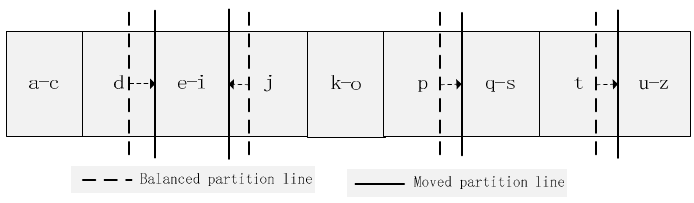
Figure 3. Balanced Partition with Partition Line Adjustment (BP_PLA).